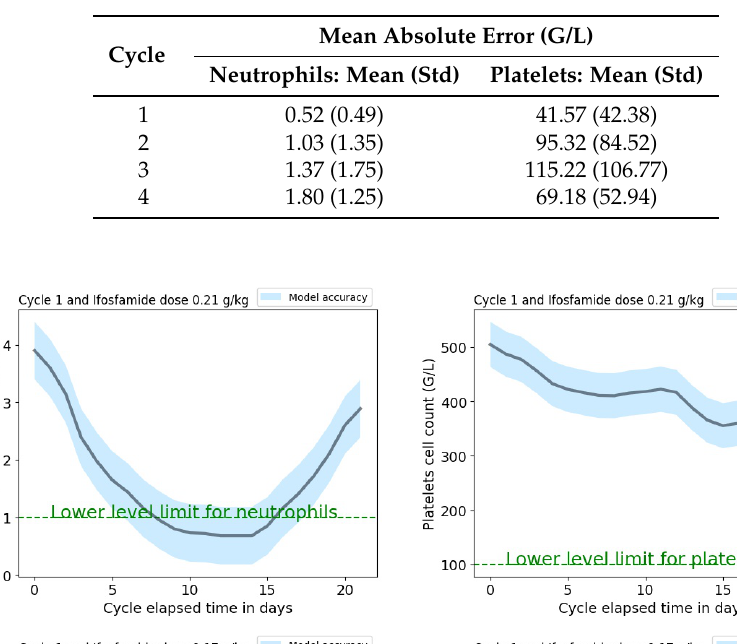
Table 5. Mean absolute error and standard deviation for neutrophils and platelets models for the first four IVA treatment cycles. These errors are computed from patients’ median absolute errors over one cycle shown in Table 4.